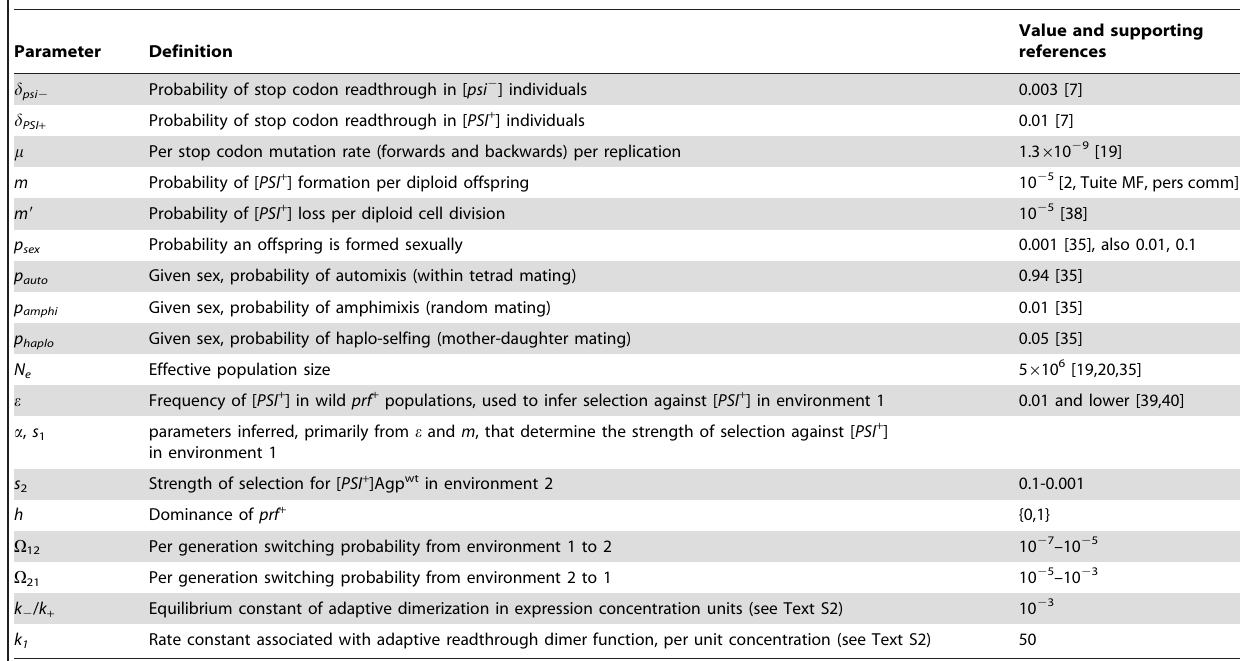
Table 1. Parameters in the